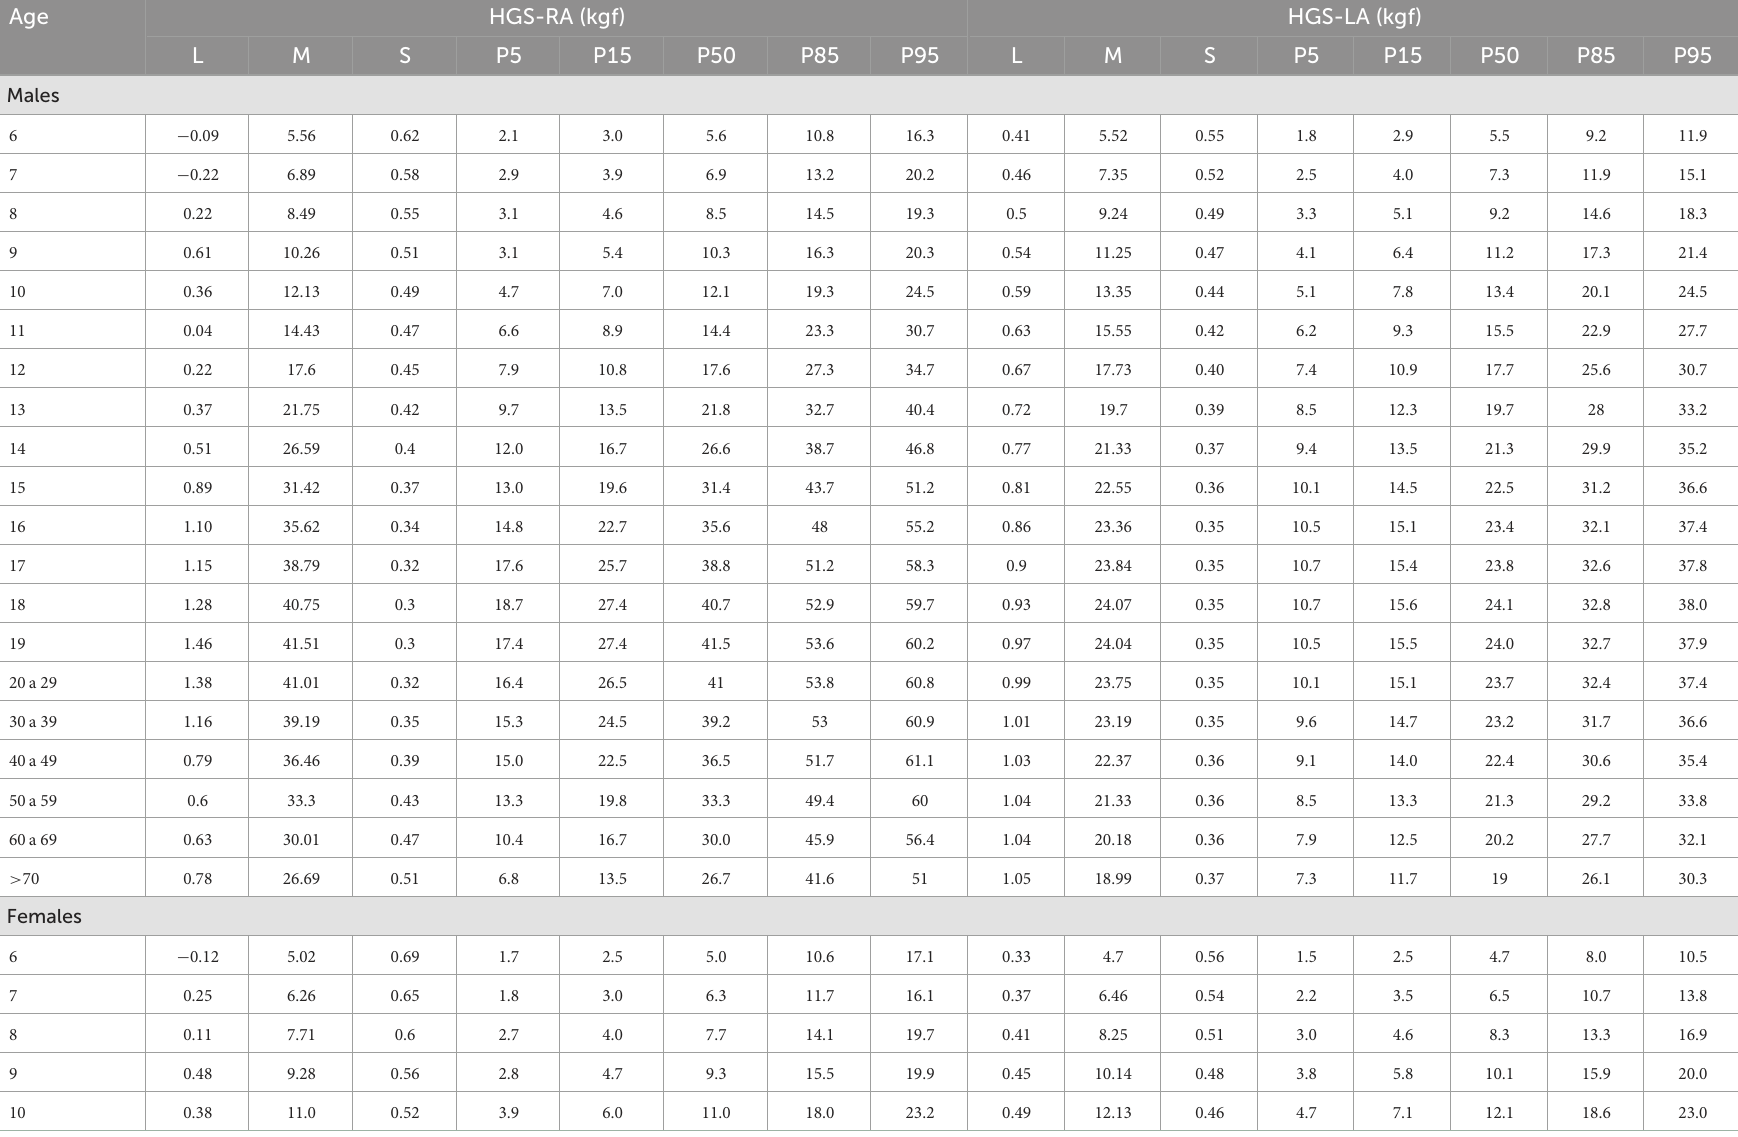
TABLE 2 Percentiles to evaluate HGS from 5 to 80 years according to age range for both sexes. Age HGS-RA